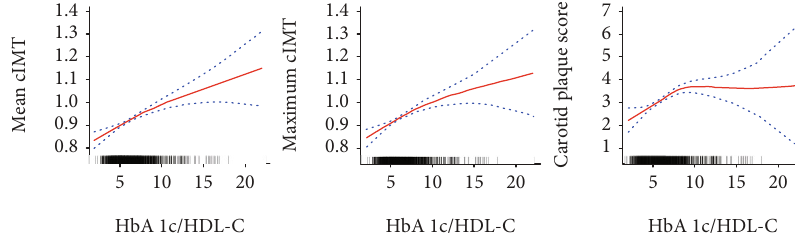
Figure 2: Dose – response relationship between the HbA1c/HDL-C ratio and carotid atherosclerosis. The area between the two dotted lines represents the 95% con fi dence interval. (a) Mean cIMT ( P for linear trend: < 0.001); (b) maximum cIMT ( P for linear trend: < 0.001); (c) carotid plaque score ( P for linear trend: < 0.001). HbA1c: hemoglobin Alc; HDL-C: high-density lipoprotein cholesterol; cIMT: carotid intima-media thickness. Table 2: OR (95% CIs) of abnormal cIMT and carotid artery plaque by quartiles of the HbA1c/HDL-C ratio.